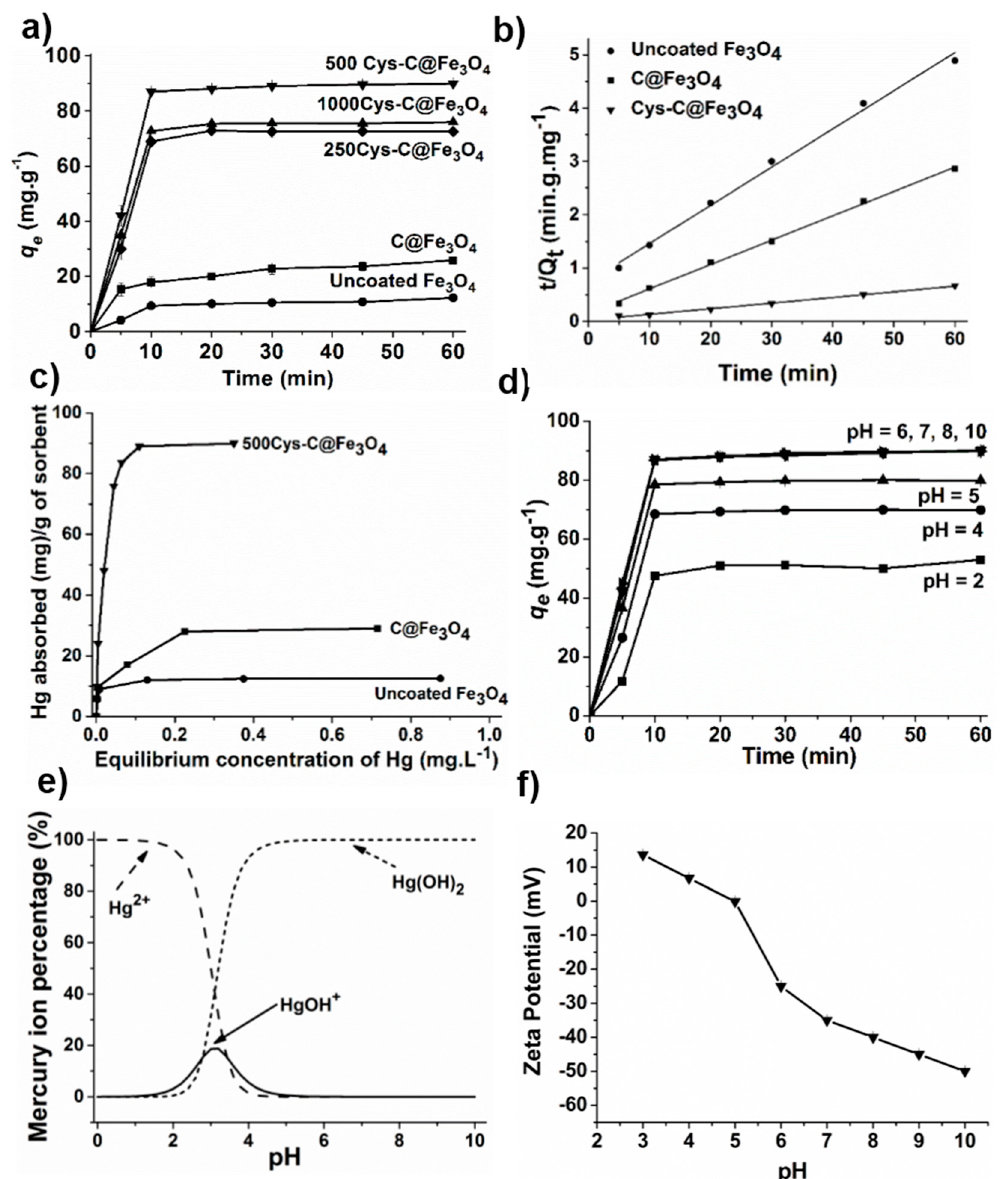
Figure 5. ( a ) Adsorption kinetics; ( b ) pseudo - second - order kinetic plot for Hg ( II ) adsorption; ( c ) Langmuir adsorption isotherms of uncoated Fe 3 O 4 , C@Fe 3 O 4 , and Cys - C@Fe 3 O 4 ; ( d ) effect of pH on Hg ( II ) adsorption by 500Cys - C@Fe 3 O 4 ; ( e ) Hg ion speciation diagram with pH as simulated using the Visual MINTEQ 3 . 1 software ( C Hg ( total ) = 1000 ppb ); and ( f ) zeta potential of 500Cys - C@ Fe 3 O 4 particles at different pH values . Small standard deviations from five identical batch experiments shown in Figure 5a,d implied the high data reproducibility.